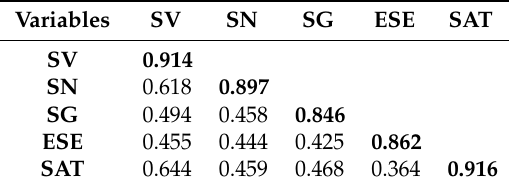
Table 3. Discriminant validity assessment for research variables.